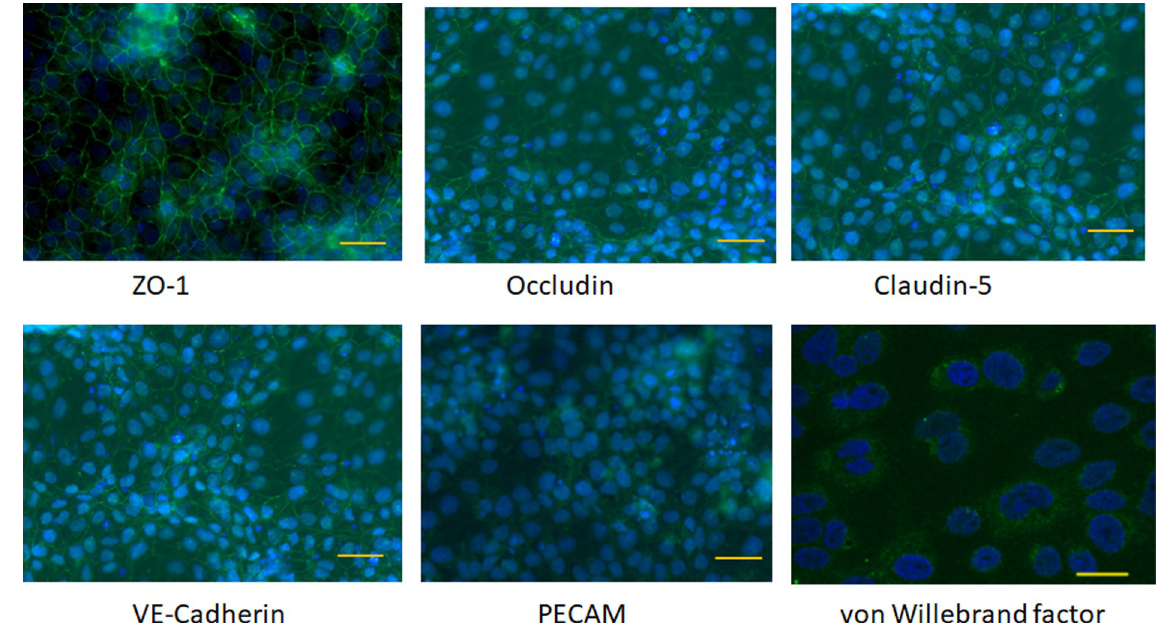
Fig 2. Immunofluorescence micrographs of differentiated (d10) endothelial-like cells showing junctional expression of ZO-1, occludin, claudin-5 and VE-cadherin, weak surface expression of PECAM and granular expression of von Willebrand factor in the cytoplasm (green). The cell nuclei were stained with DAPI (blue). Scale bars = 50 μ m. Scale bar on VWF = 20 μ